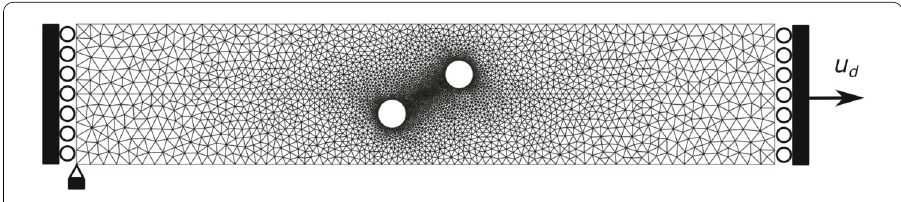
Fig. 8 Example of the orthotropic specimen with two holes: boundary condition definition, initial geometry to be optimized and corresponding finite element mesh (inspired from [22])